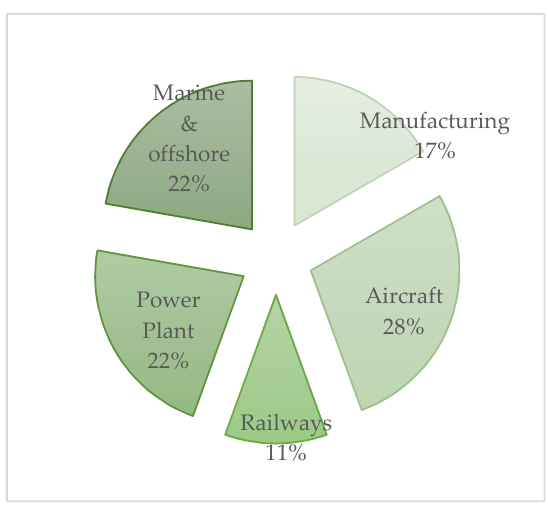
Figure 5. AM deployment for repair and restoration according to the types of industry. Figure 5 . AM deployment for repair and restoration according to the types of industry.